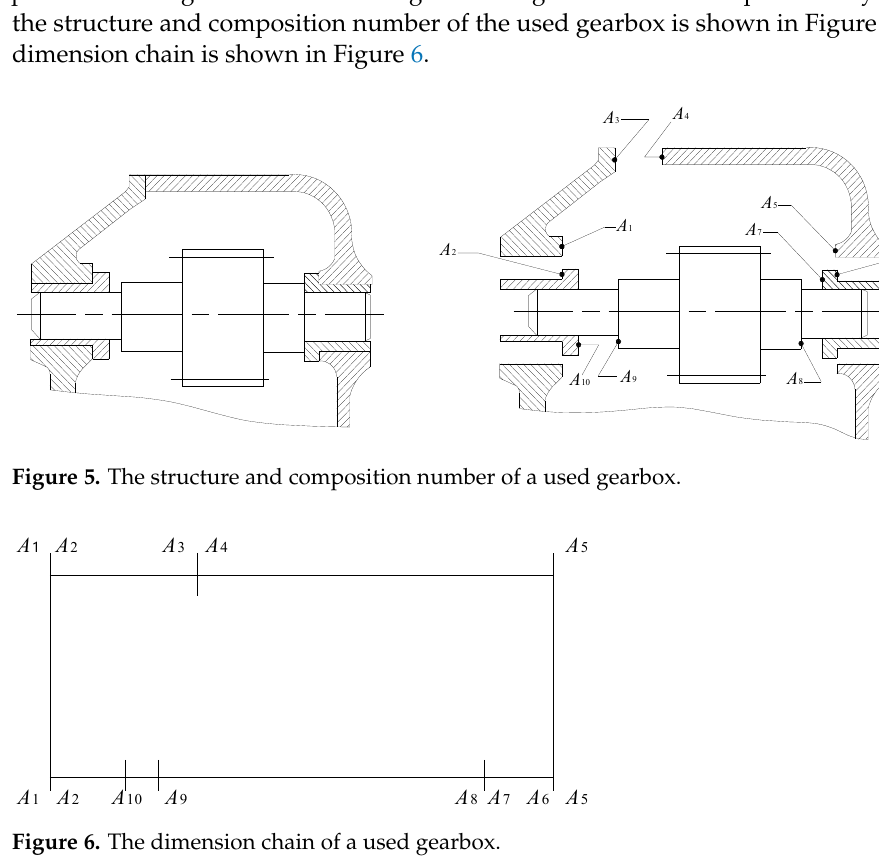
Figure 6. The dimension chain of a used gearbox.